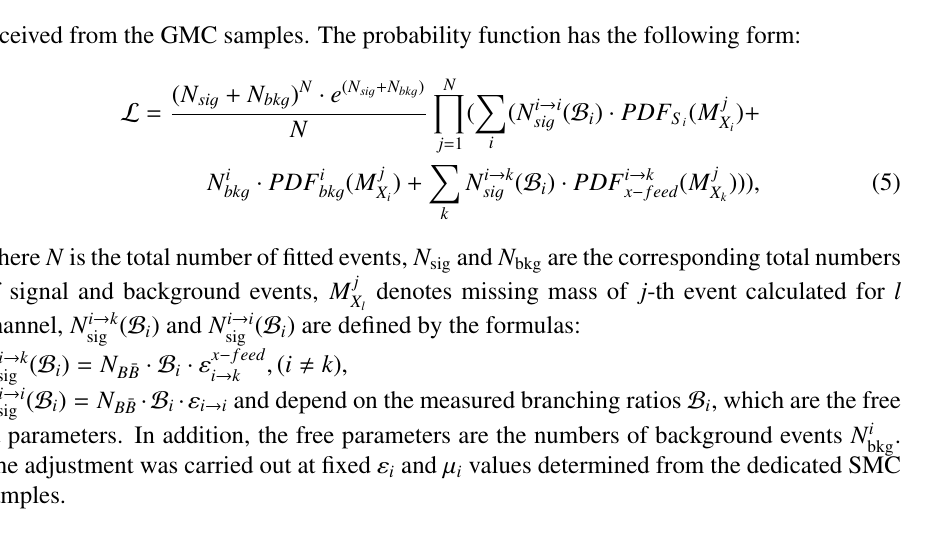
range 1.7 - 2.7 GeV X